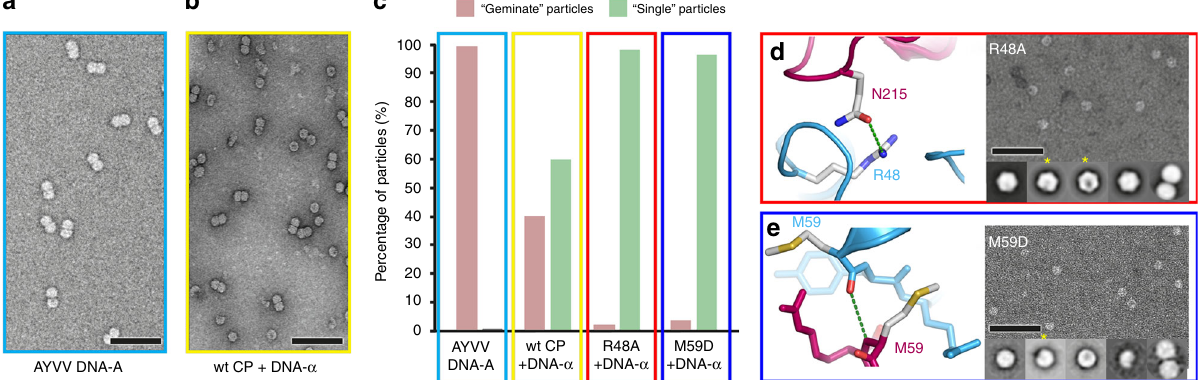
Fig. 3 In vivo assembly assay for genome encapsidation. Representative negative stain micrographs of particles produced by in fi ltration with AYVV DNA-A ( a ) or co-in fi ltration with AYVV CP and DNA − α ( b ). Relative composition of “ geminate ” particles (pink in bar chart) compared with “ single ” particles (green in bar chart) from AYVV ( c ), and co-in fi ltrations of AYVV CP, R48A, and M59D, each with DNA − α ( c ). Representative negative stain micrographs and 2D class averages are shown for R48A variant ( d ) and M59D variant ( e ). The yellow asterisk highlights 2D class averages which appear to be “ single ” VLPs with a missing pentameric capsomer. Error bar is 100 nm